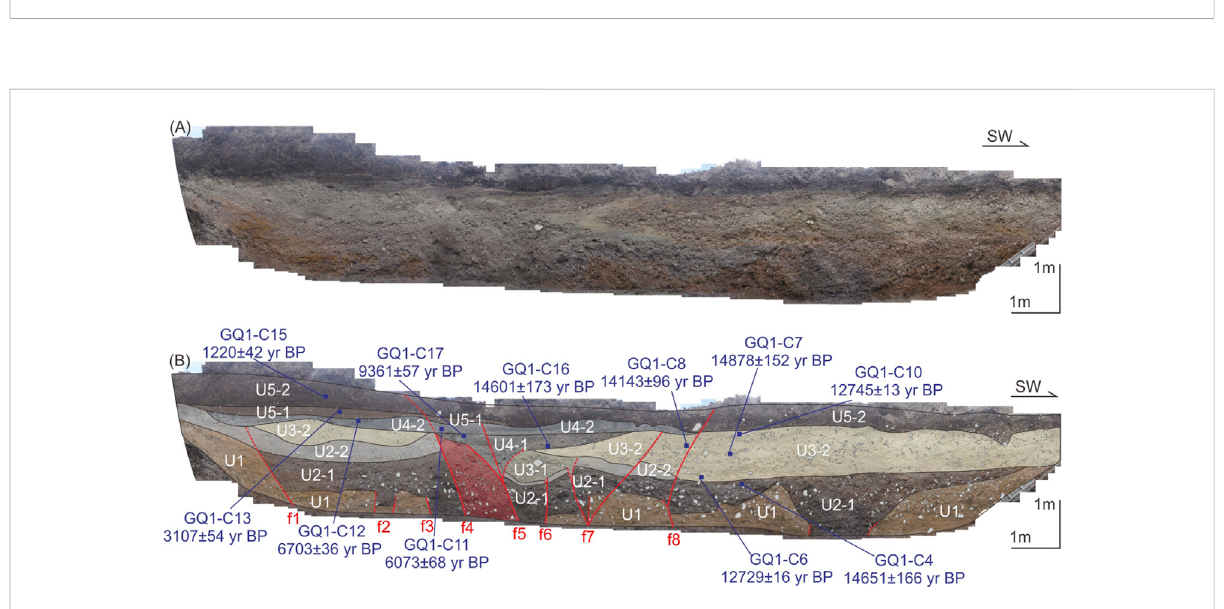
FIGURE 7 Photomosaic (A) and interpretation map (B) of the eastern wall of trench